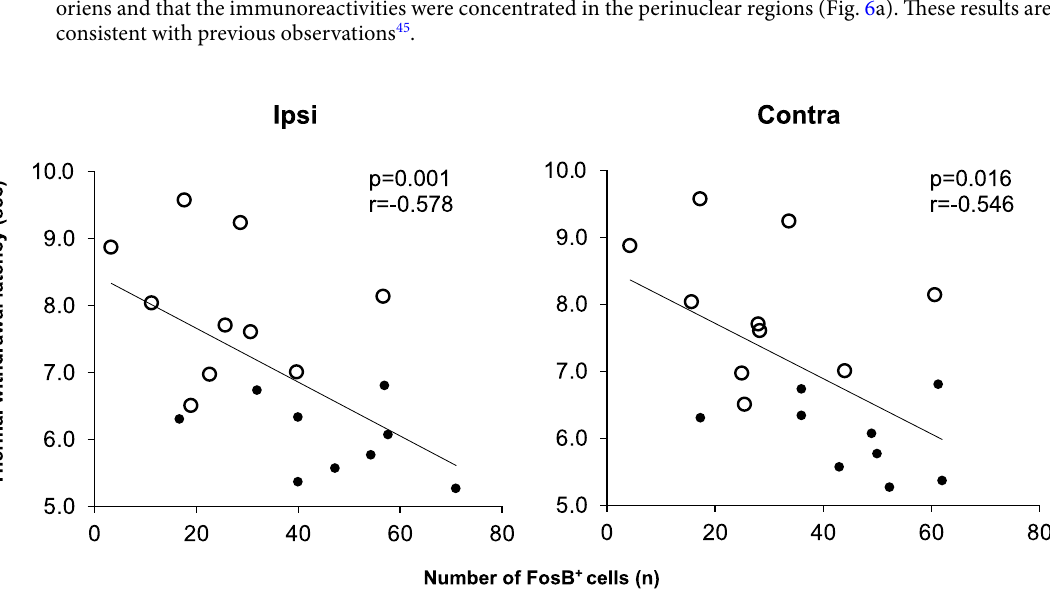
Figure 4. Relationship between the number of FosB + cells in the vHPC-CA1 and thermal withdrawal latencies in PSL-mice. A significant negative correlation was observed between the number of activated (FosB + ) neurons in the vHPC-CA1 and thermal withdrawal latencies in PSL-Sedentary mice (black circles) and PSL-Runner mice (white circles). Ipsilateral side: p = 0.001, r = 0.578, n = 19, Contralateral side: p = 0.0016, r = 0.546. n = 19. PSL partial sciatic nerve ligation, vHPC ventral